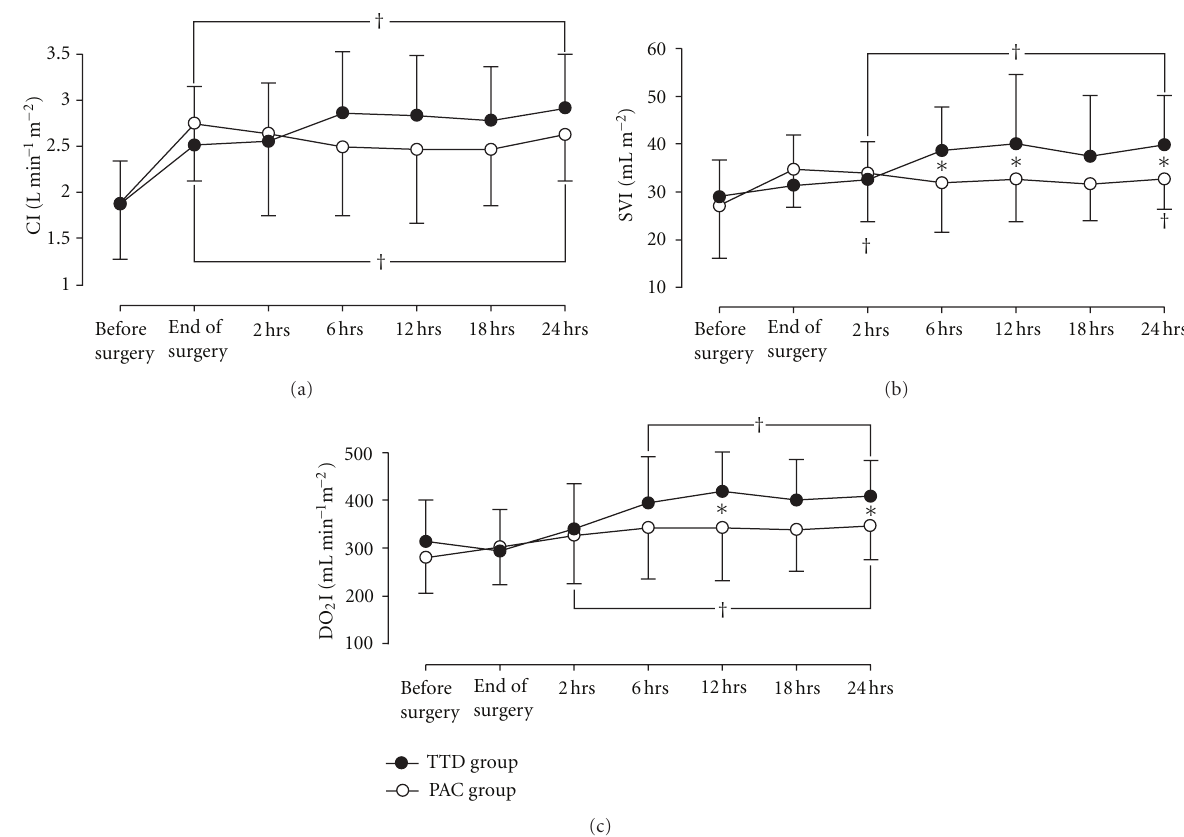
Figure 3: Changes in cardiac index, stroke volume index and oxygen delivery in the study groups. CI: cardiac index; SVI: stroke volume index; DO 2 I: oxygen delivery index. ∗ P < 0 . 05 between the groups; † P < 0 . 05 within the group compared with the preoperative value. Data are presented as mean ±